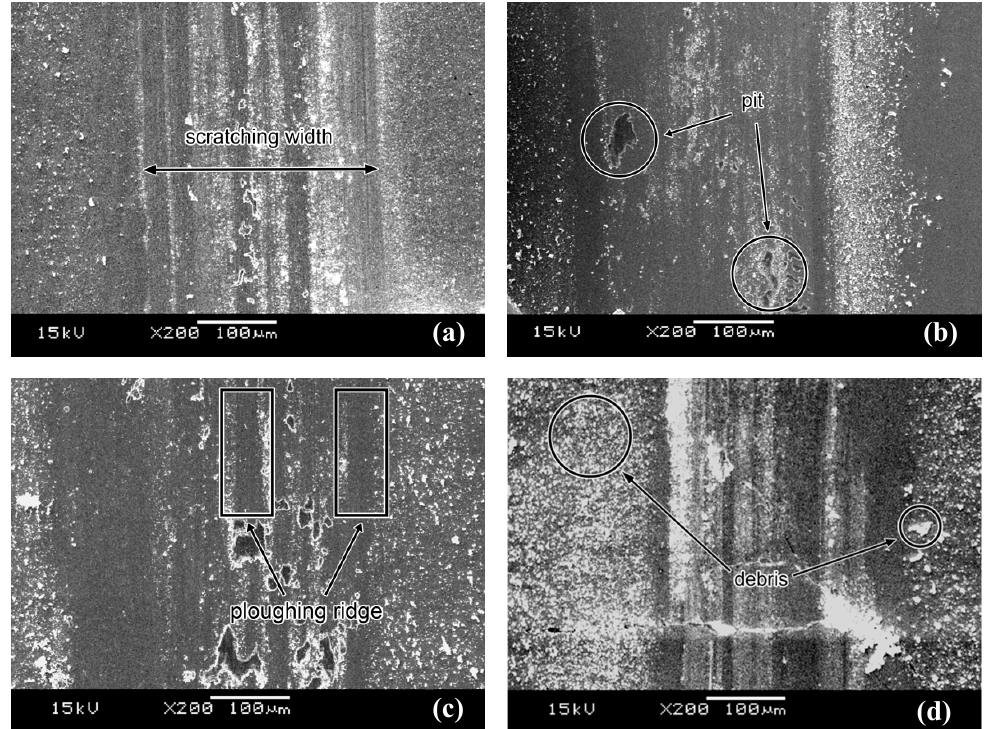
Figure 6. The worn morphologies of the coatings with different Ni contents: ( a ) Co 55.1 Ni 6.1 B 26.2 Si 7.8 Ta 4.8 ; ( b ) Co 49.0 Ni 12.2 B 26.2 Si 7.8 Ta 4.8 ; ( c ) Co 42.8 Ni 18.4 B 26.2 Si 7.8 Ta 4.8 ; ( d ) Co 36.8 Ni 24.4 B 26.2 Si 7.8 Ta 4.8 .